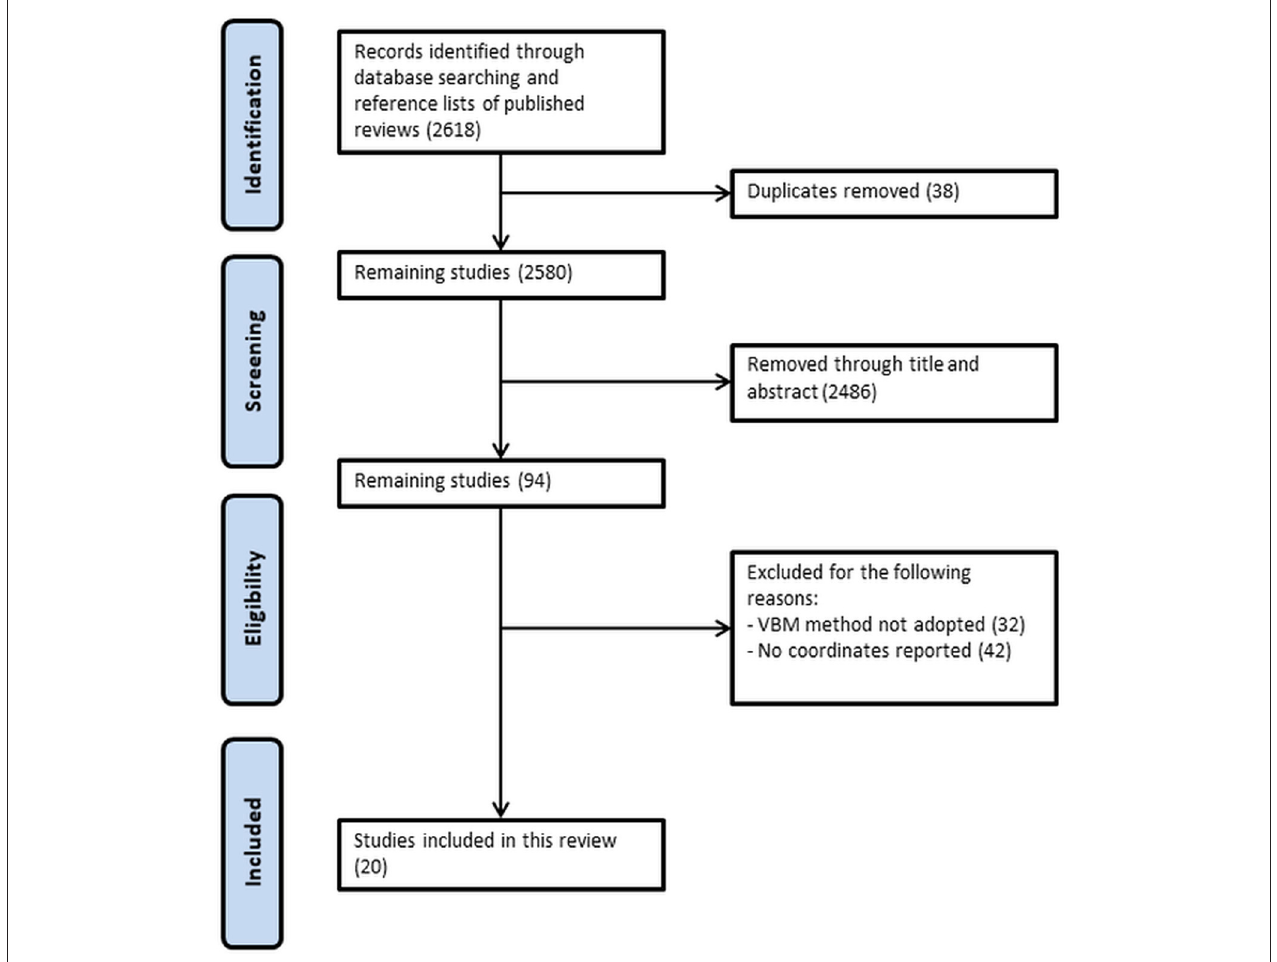
FIGURE 1 | Preferred Reporting Items for Systematic Reviews and Meta-analyses (PRISMA) flow diagram of search